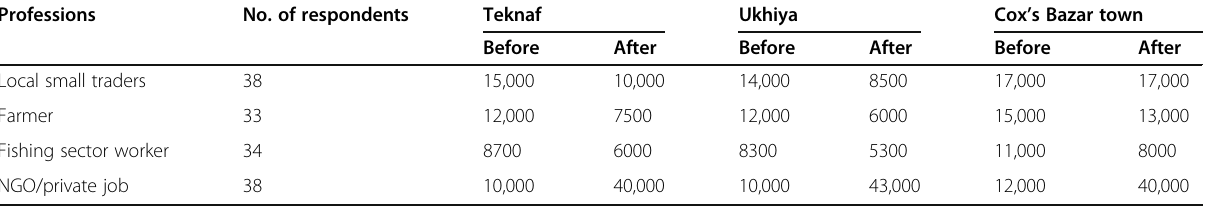
Table 3 Average monthly income (in BDT) of the respondents (before and after the refugee arrival in 2017 Professions No. of